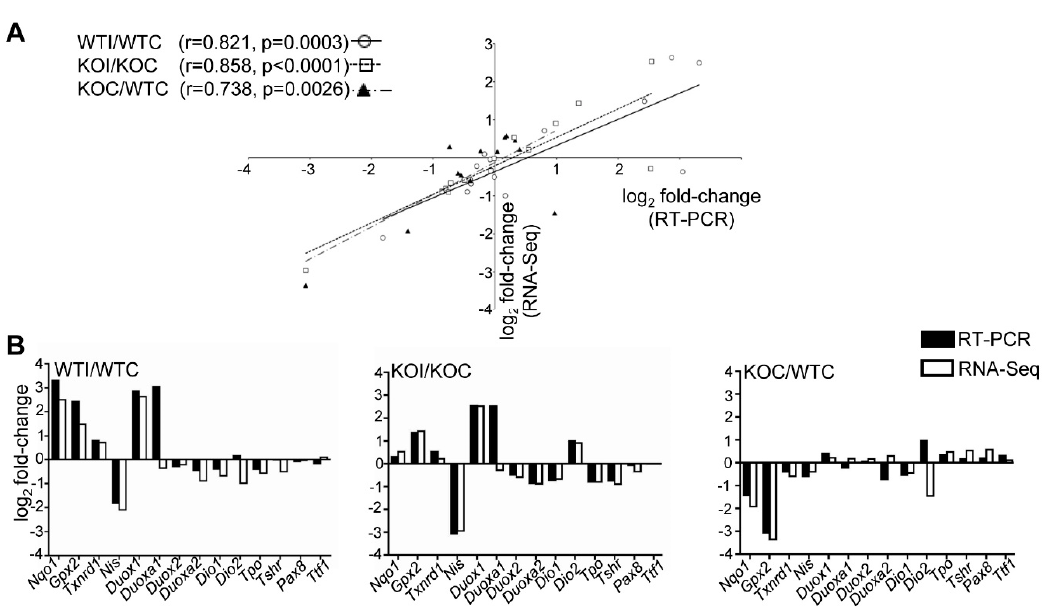
Figure 3. ( A ) RNA-Seq data validation by RT-PCR. Correlation of the expression fold changes between RNA-Seq and RT-PCR of 14 selected genes in WT mice after iodide treatment (WTI / WTC, circles and solid line, Pearson’s correlation coe ffi cient r = 0.821, p = 0.0003), in Nrf2 KO mice after iodide (KOI / KOC, squares and dashed line, Pearson’s r = 0.858, p < 0.0001), and in Nrf2 KO versus WT without excess iodide (KOC / WTC, triangles and dashed line, Pearson’s r = 0.738, p = 0.0026). ( B ) Fold changes of each of the genes used for correlation analysis depicted according to the measurement method (black bars, RT-PCR; white bars, RNA-Seq) and the relevant comparison (WTI / WTC, KOI / KOC, or KOC / WTC). RT-PCR was performed in all study samples (WTC, n = 9; WTI, n = 12; KOC, n = 10; KOI, n = 10), while RNA-Seq was performed in 3 / 9, 4 / 12, 4 / 10, and 5 / 10 samples, respectively.